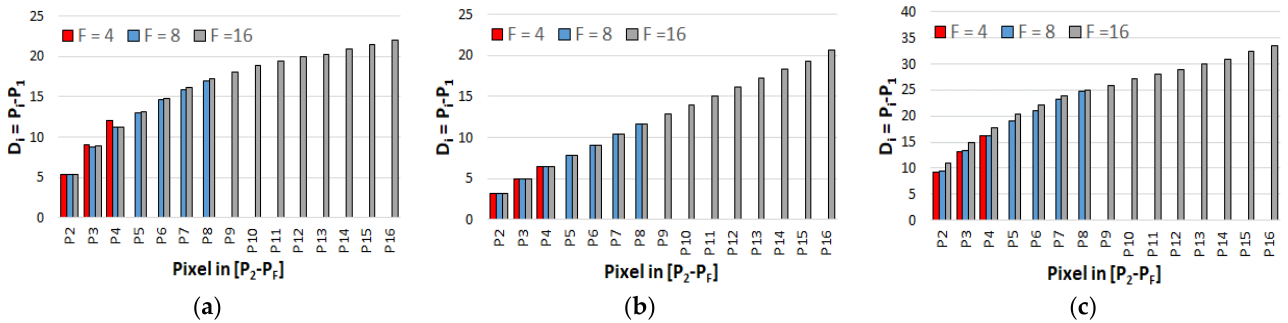
Figure 3. Analysis of the pixel value differences for different values of F and for the analyzed benchmarks: ( a ) airplane, ( b ) dark woman, ( c ) lake.